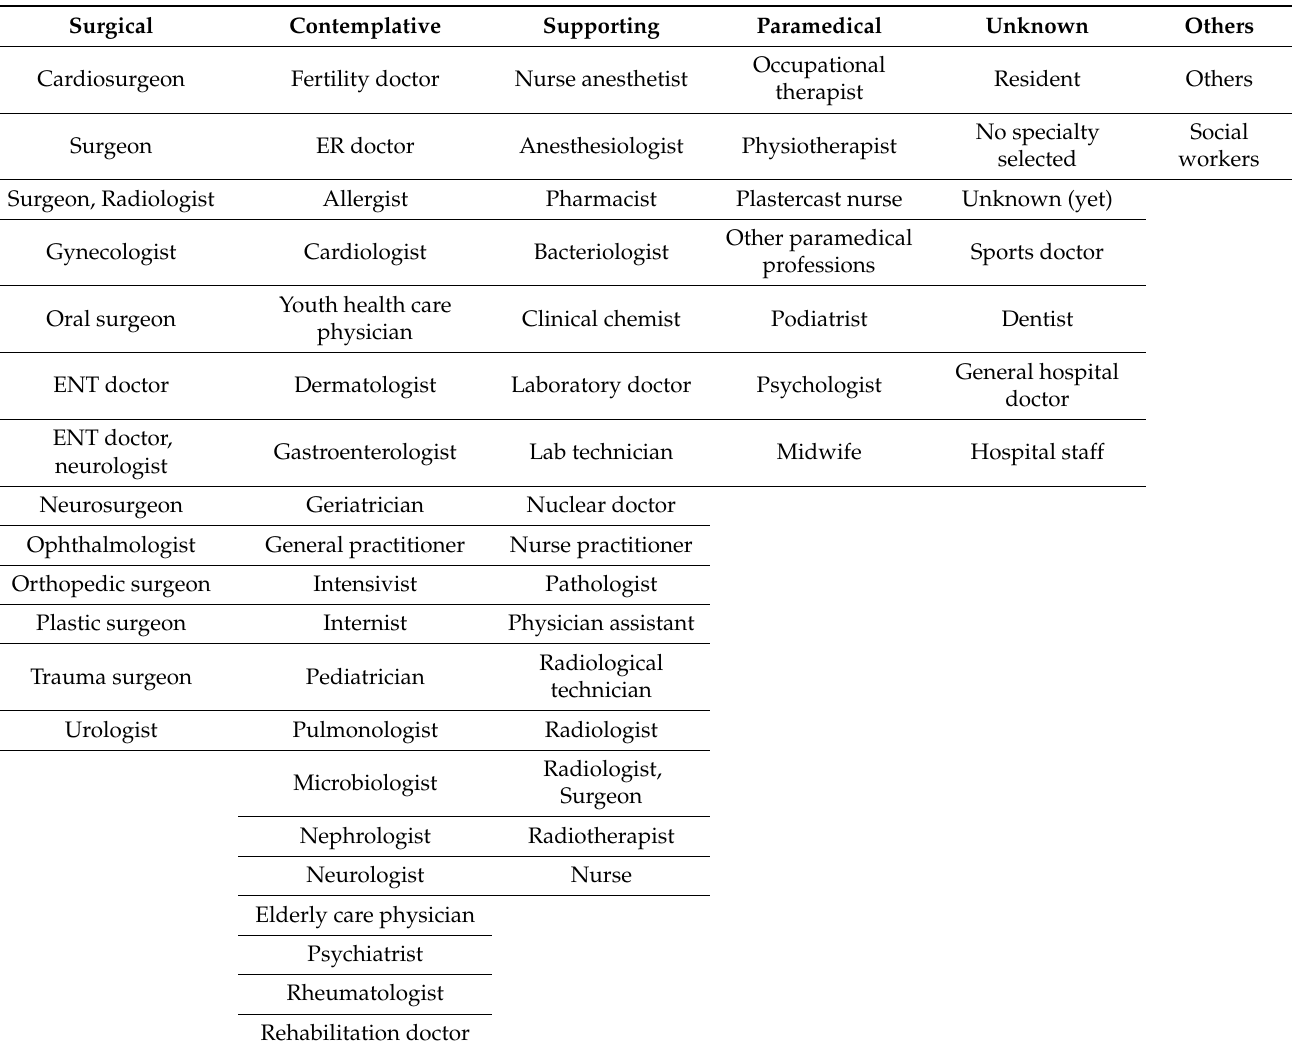
Table 1. Medical specialties per